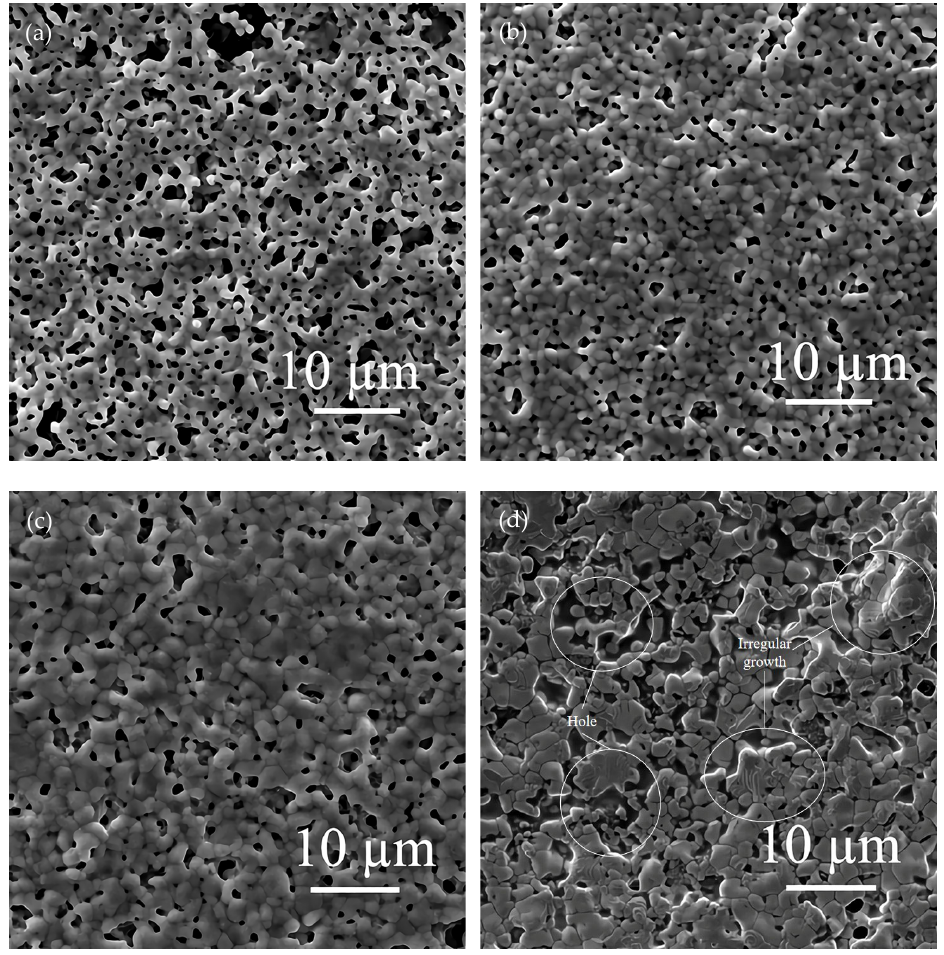
Figure 4. Surface morphology of sintered silver pastes at different temperatures. Images in ( a – d ) are for the silver paste with spherical silver powder sintered at 600, 700, 800, and 900 °C, respectively.